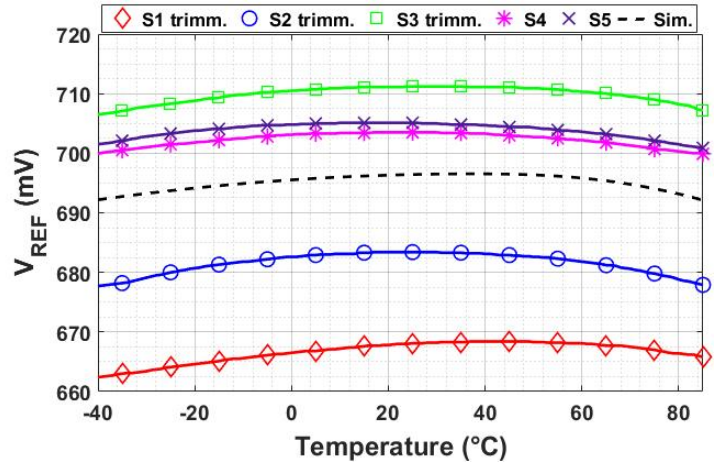
Figure 16. Measured V REF as a function of temperature for five chip samples (untrimmed).